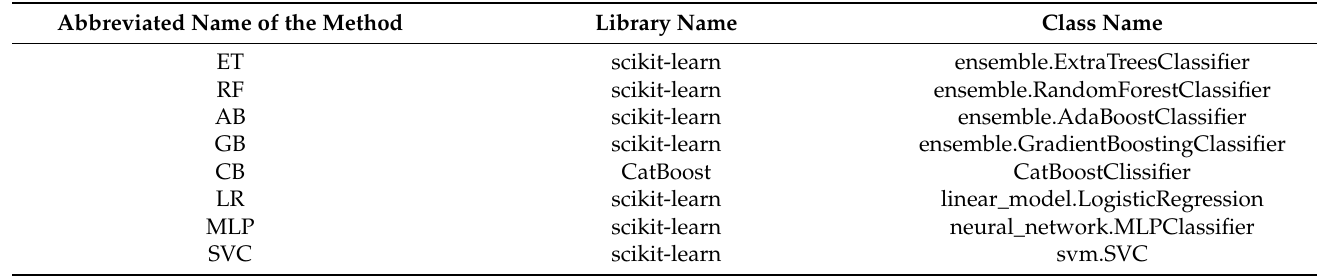
Table 3. The list of methods and classes implementing them.